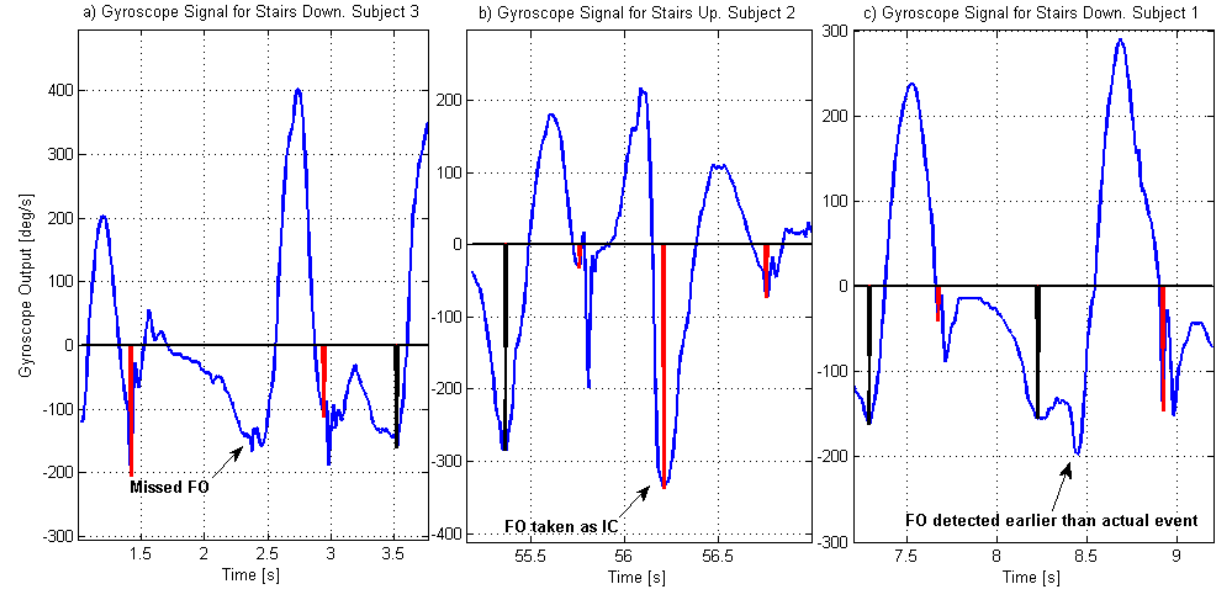
Figure 4. Causes for missed or wrongly detected FO events. Gyroscope signals